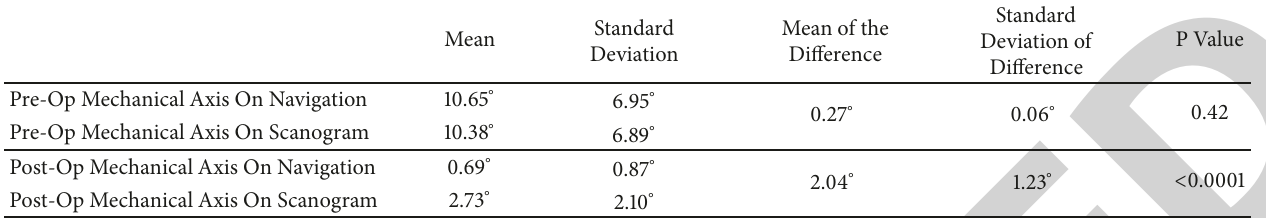
Table 1: Measured Limb Alignment on Navigation and